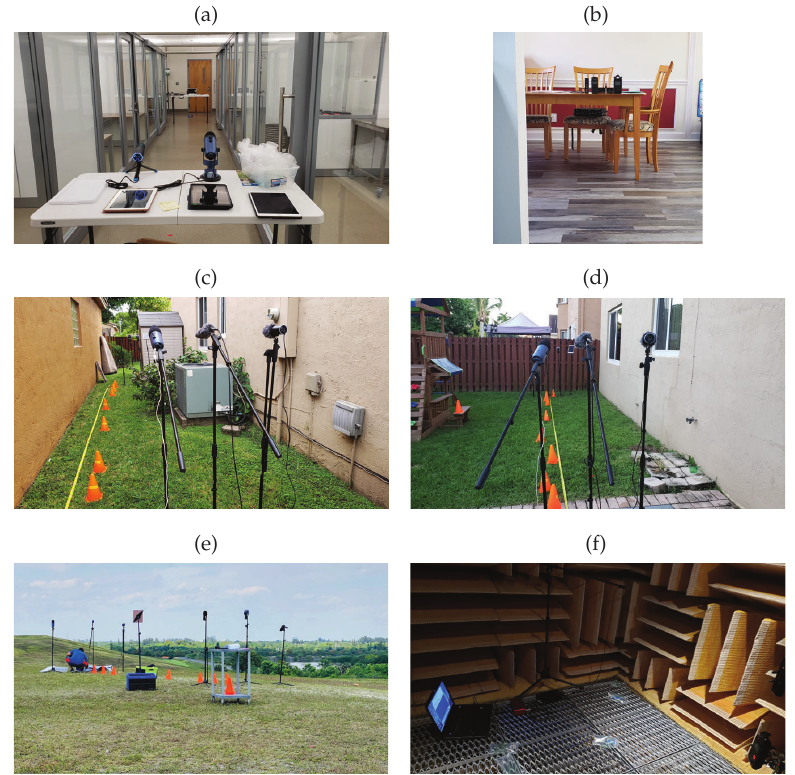
Figure 1. Images of some of the various environments used for the capture of the plastic bag popping sounds (class 8): ( a ) along glass corridor, ( b ) inside of personal dwelling, ( c ) between two buildings, ( d ) side of building, ( e ) open field and, ( f ) anechoic chamber